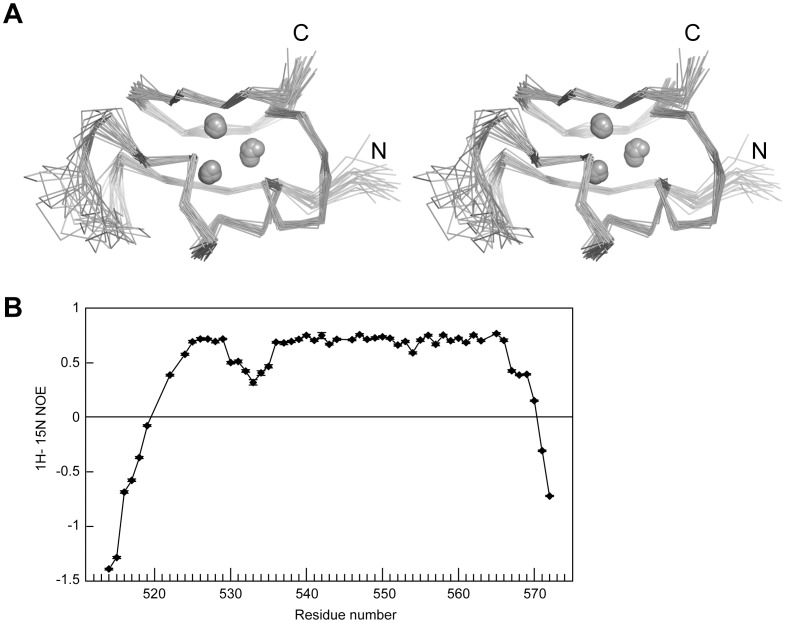
NMR structure and dynamics of MSL2 CXC domain.(A) Structural superposition of the 20 lowest energy NMR structures. The Cα traces of residues 521–566 and three zinc ions (spheres) are shown in cross-eye stereoview. (B) Steady-state 1H-15N heteronuclear NOE values are plotted as a function of residue number. The experiment was conducted for CXC-2, which contains residues 517–572 plus three extra N-terminal residues from the vector. No data were obtained for proline residues that lack amide proton. Error bars represent the experimental uncertainties estimated from the spectrum background noise.